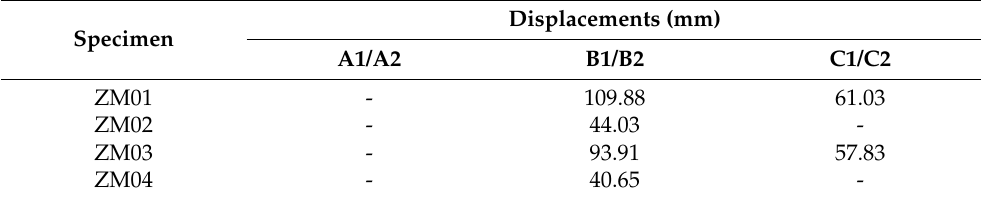
Table 7. Displacements corresponding to reinforcement stresses reaching yield stress.